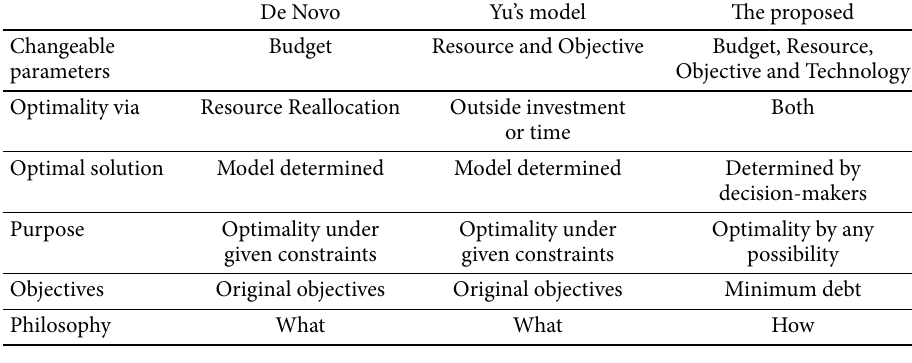
Table 6. The differences between the system design of the models De Novo Yu’s model The proposed